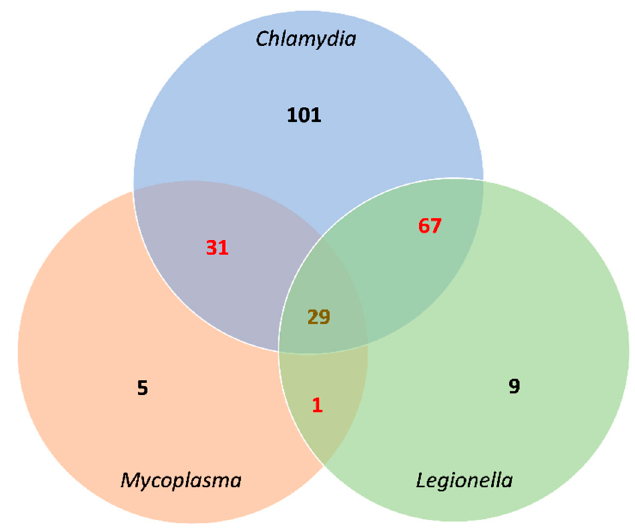
Figure 4. Venn diagram shows the overlapping of IgG seropositivity results between different bacterial species. Black numbers for IgG seropositivity without overlapping with other species. Red numbers for IgG seropositivity with overlapping between two species. Brown number for IgG seropositivity with overlapping between three species.